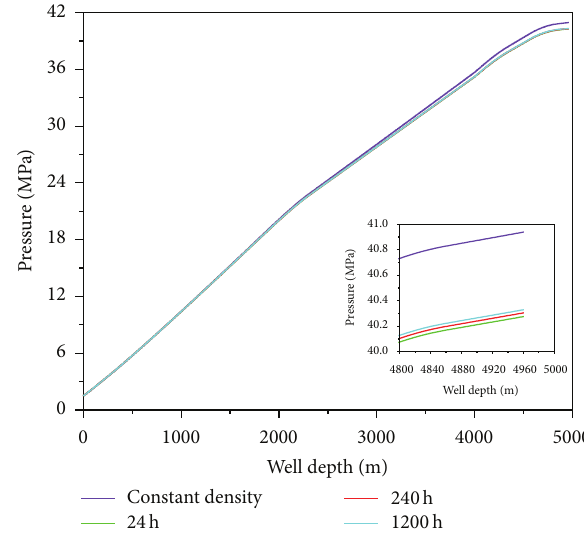
Figure 17: Time-averaged measured and estimated standpipe pres- sure and surface casing pressure when every zone were being penetrated.